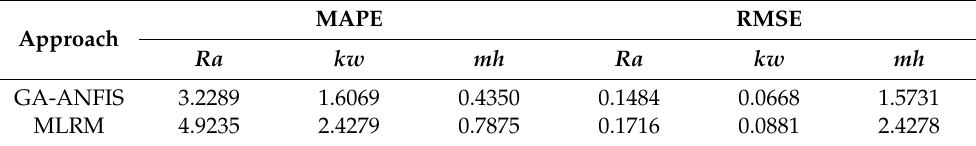
Table 6. Statistical validation results of proposed ANFIS-GA vs. MLRM.